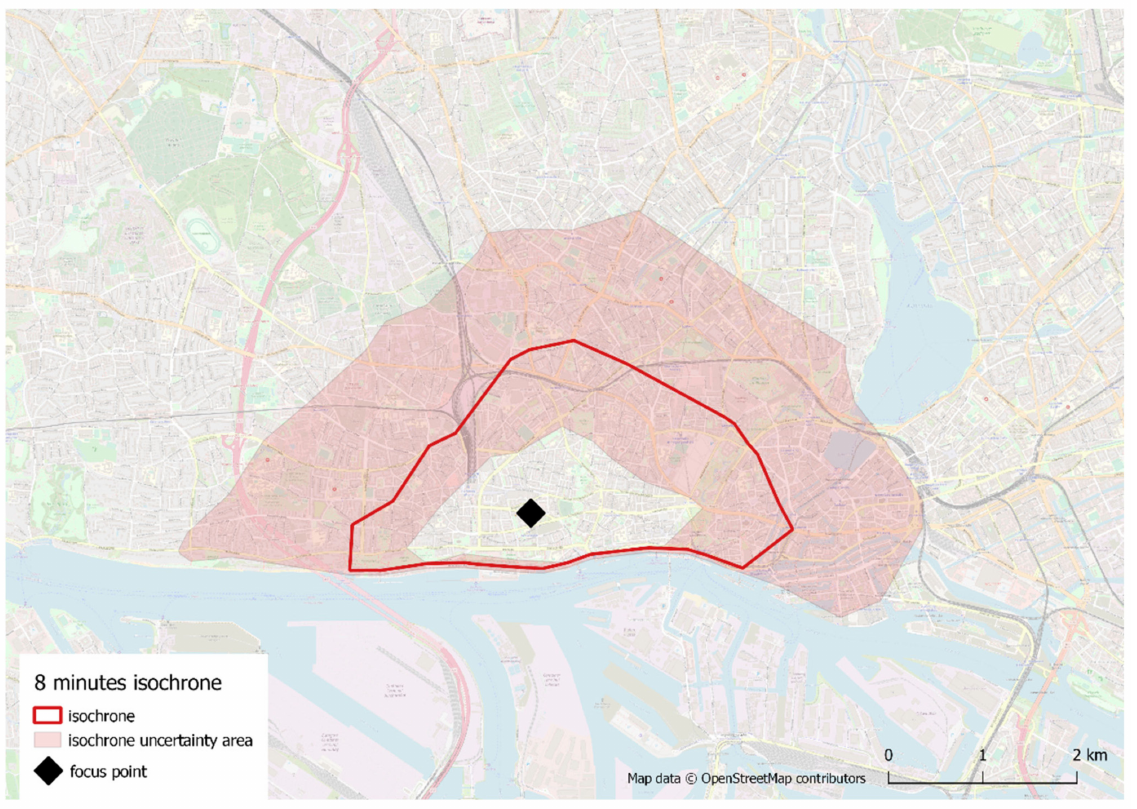
Figure 6. Example 2: Spatial variance around eight minute’s isochrones, expressed by single buffer. The visualization uses the isochrone as a basis, on which the uncertainty symbolization is applied as follows: explicit, extrinsic (transparent, single-colored polygon showing distance buffer with regard to isochrone), coincident, integral, and